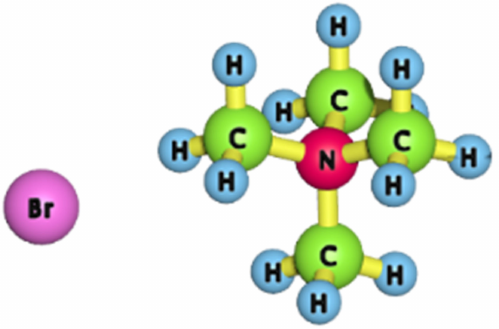
Figure 6. Three-dimensional structure of tetraethylammonium bromide (TEAB).